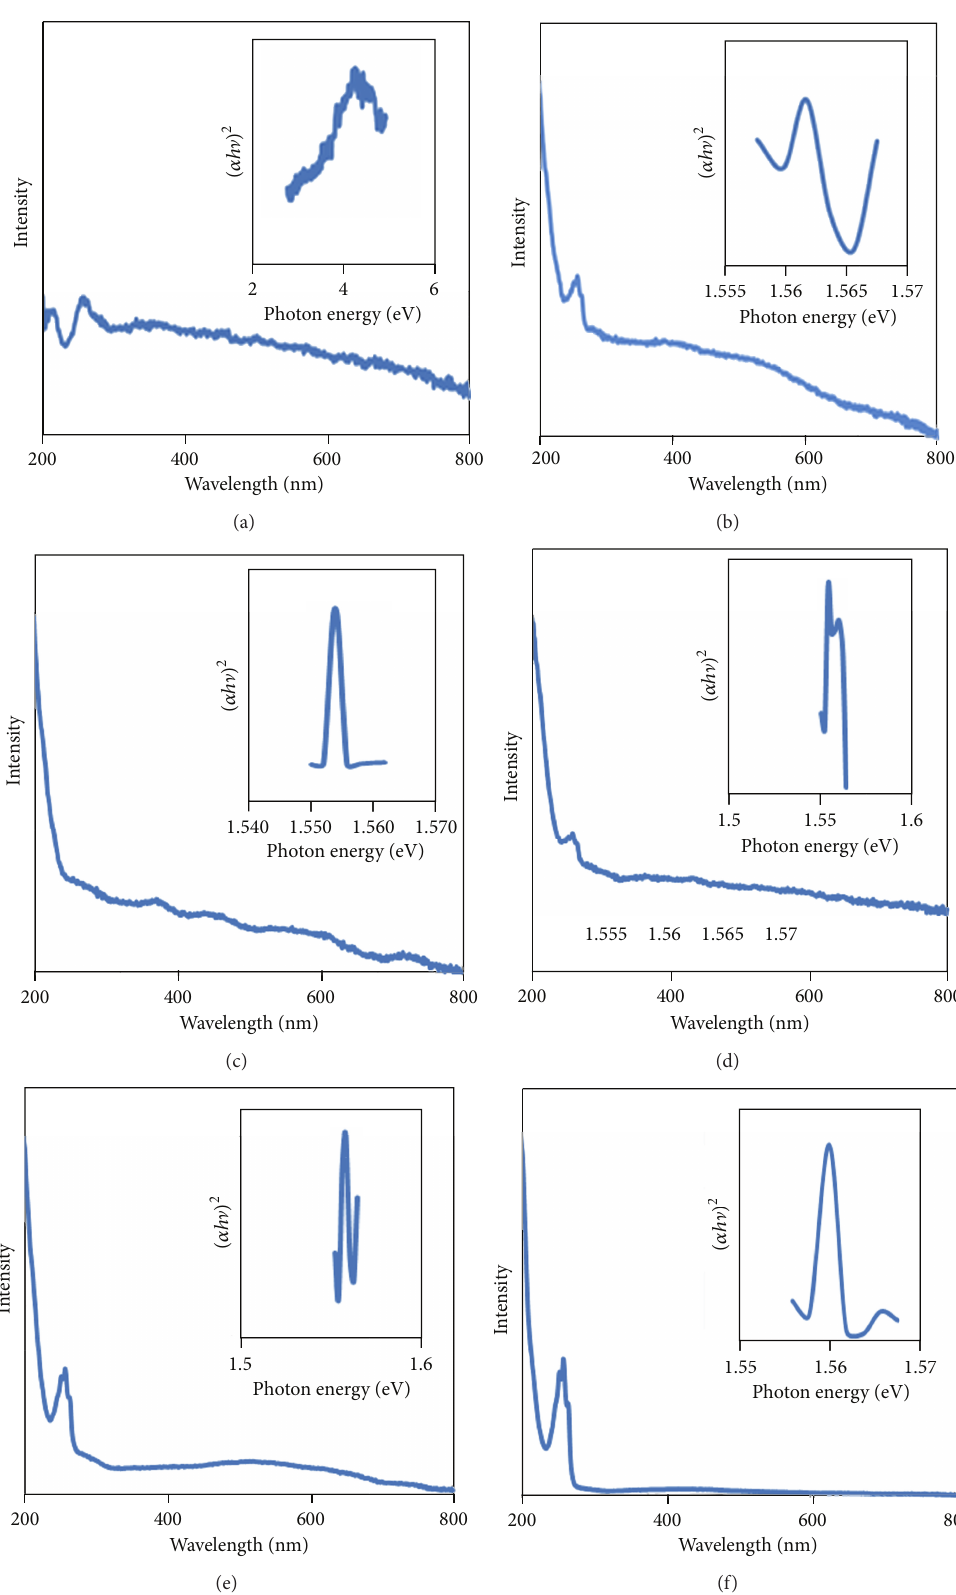
Figure 12: Optical absorbance spectra of functionalized 𝛼 CNTN/Ag nanohybrids at different molars of AgNO 3 : (a) 0 M, (b) 0.01M, (c) 0.05 M, (d) 0.1M, (e) 0.5 M, and (f) 1M. Inset shows Tauc plot for each